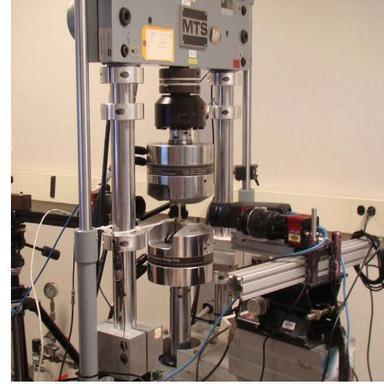
Redundancy test setup using an MTS 312.21 100 kN servohydraulic loadframe with monitoring using both thermal and optical cameras.